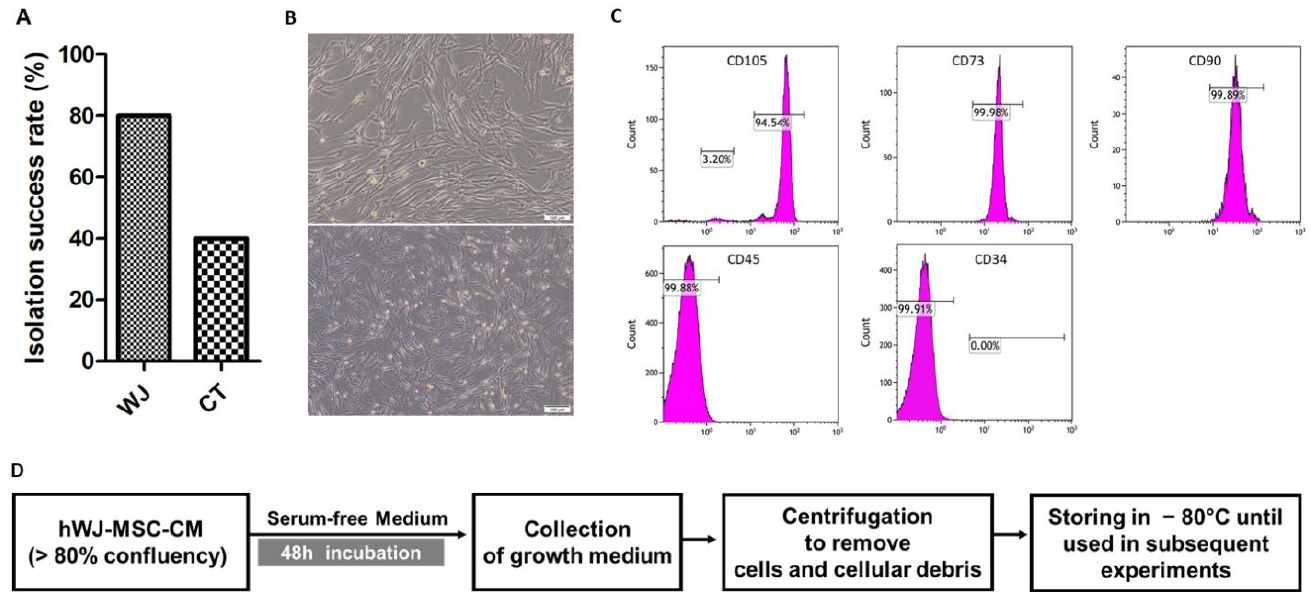
Figure 1. Isolation and characterization of hUCMSCs. ( A ) Percentage of the isolation success rate of hUCMSCs. ( B ) Morphology of hWJ-MSCs was observed under light microscopy at 200× magnification. ( C ) Flow cytometry characterization of hWJ-MSCs demonstrates positive expression of mesenchymal stem cells markers: CD105, CD73, CD90, and negative expression of hematopoietic stem cells markers: CD45, and CD34. ( D ) Schematic depicting the collection of hWJ-MSCs secretome.